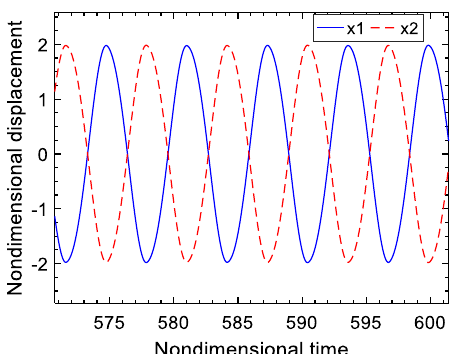
Figure 13. Nondimensional displacement curves of the two masses (𝛾 𝑛𝑒𝑡 = 0.9) .